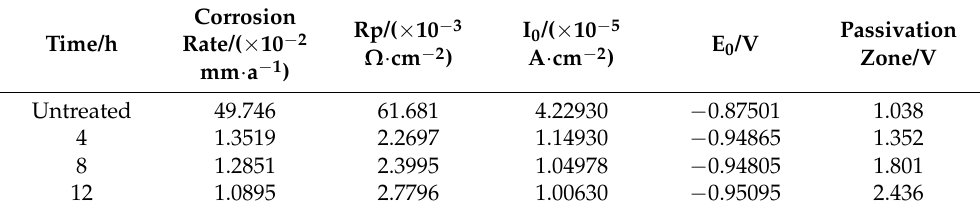
Figure 6. Corrosion resistance curve of modified layer of 3Cr13 steel after plasma nitriding at different times ( a ) Without RE ( b ) With RE. Table 1. Fitting data of the polarization curve of the modified layer of 3Cr13 steel after plasma nitriding at different times.